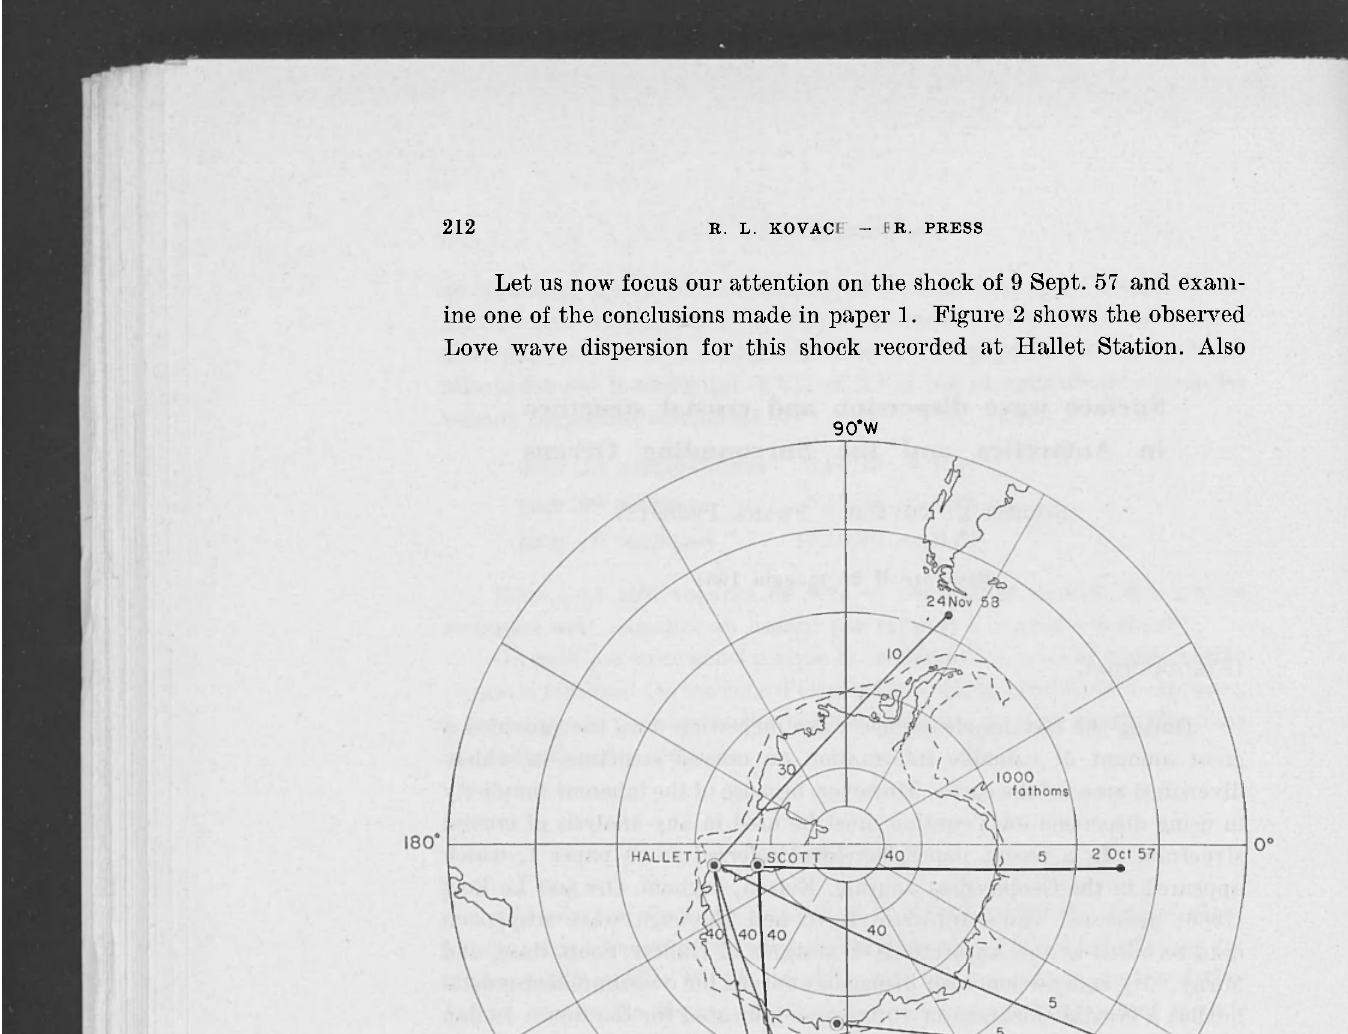
Fig. J - Index map showing epicenters, seismograph stations, great circle paths and deduced crustal thicknesses for the Antarctic